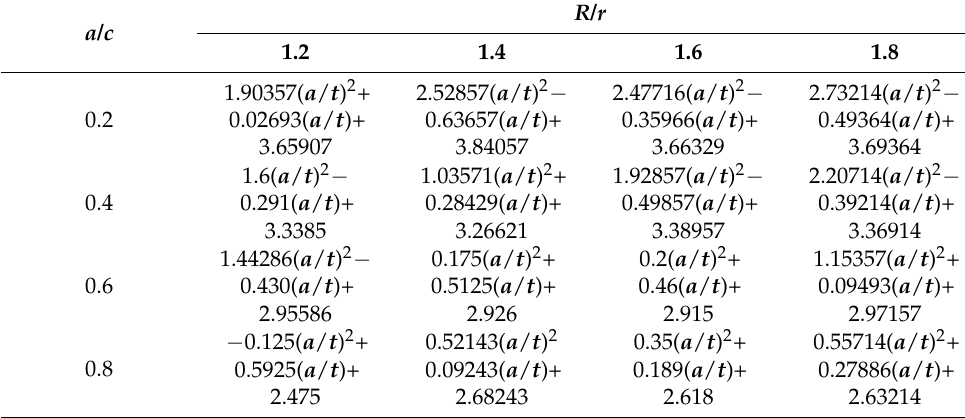
Table 3. The binomial fitting results of the corrected shape coefficient F I and the crack relative depth.